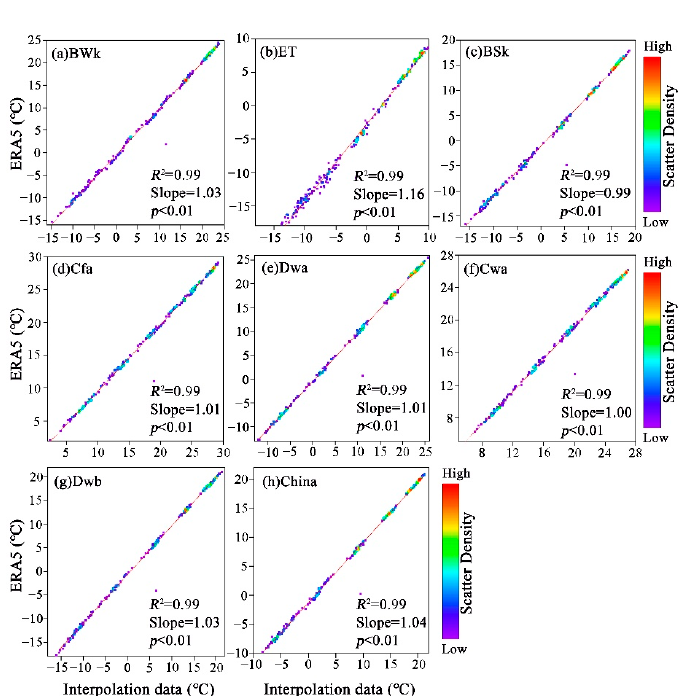
Figure 12. Comparison and verification of interpolation data and the European Centre for Medium- Range Weather Forecasts Reanalysis 5 (ERA5) data of temperature for selected Köppen–Geiger clas- Table 3 for explanations of the abbreviations).